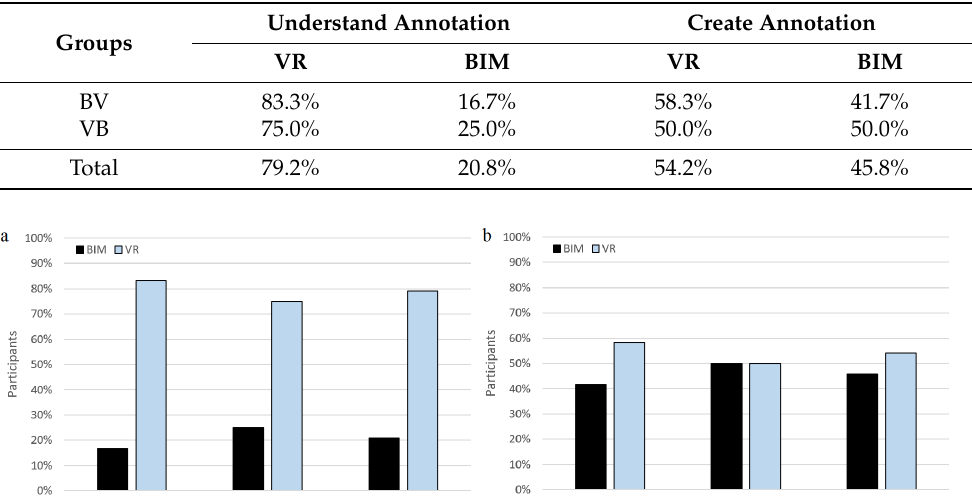
Table 1. Participants’ platform preferences to understand and create annotations.